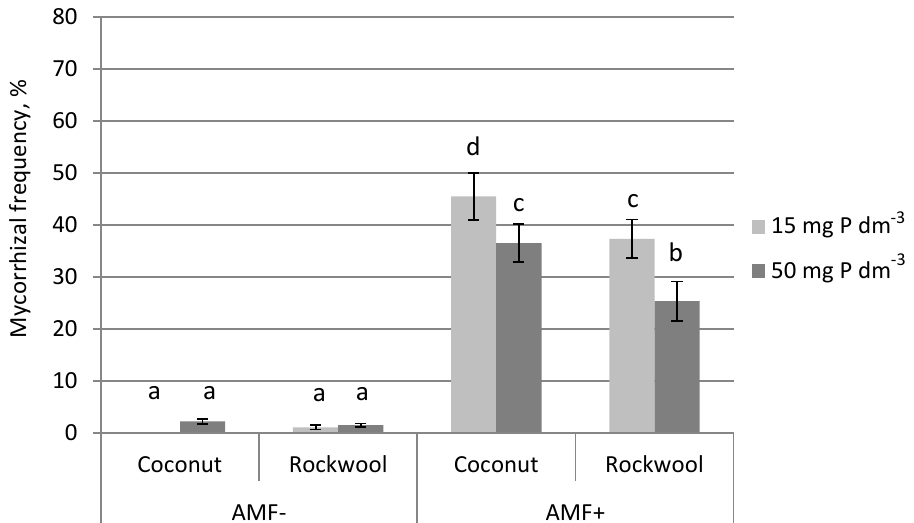
Fig. 1. Interaction between phosphorus level in nutrient solution, mycorrhiza and type of substrate on mycorrhizal frequency in roots of tomato plants; 1. period of isolation (82 days after transplanting (DAT)) Means followed by different letters differ at p < 0.05.; bars indicate standard error AMF-/AMF+ – non-inoculated plants by arbuscular mycorrhizal fungi (AMF)/inoculated plants by AMF